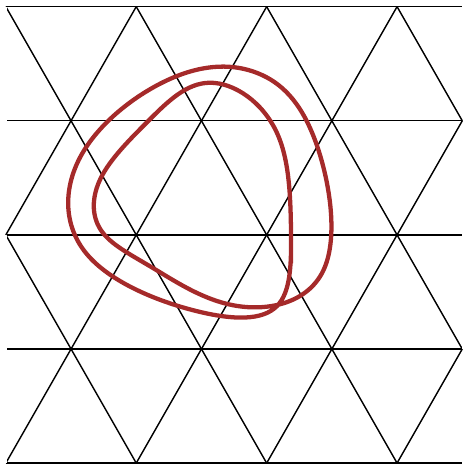
Figure 4 . The hexagon diagram in the 3 dimensional (cid:12)shnet model and the path on the lattice that produces it. External legs could be contracted with each other or with other tiles. Di(cid:11)erent (cid:12)elds in the diagram are painted with di(cid:11)erent colors. In the lattice, the type of (cid:12)led is uniquely determined by the direction of the line.